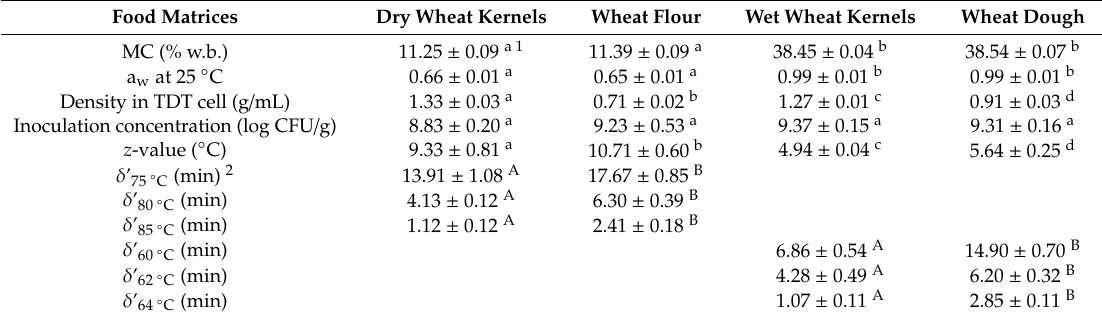
Table 1. Basic properties of materials and the e ff ect of the di ff erent physical structure of food matrices on the heat resistance of E. faecium